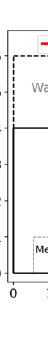
Figure 1. The sketch of the experiment. The exit width is fixed as 0.7 m. The measurement area (2 m × 1 m) is selected to measure the time evolution of density and speed in “Time profiles of density and speed” section. To measure the movement characteristics of pedestrians, the coordinate system takes the lower-left corner as the origin point, the direction parallel to the exit as the X-axis, and the direction perpendicular to the exit as the